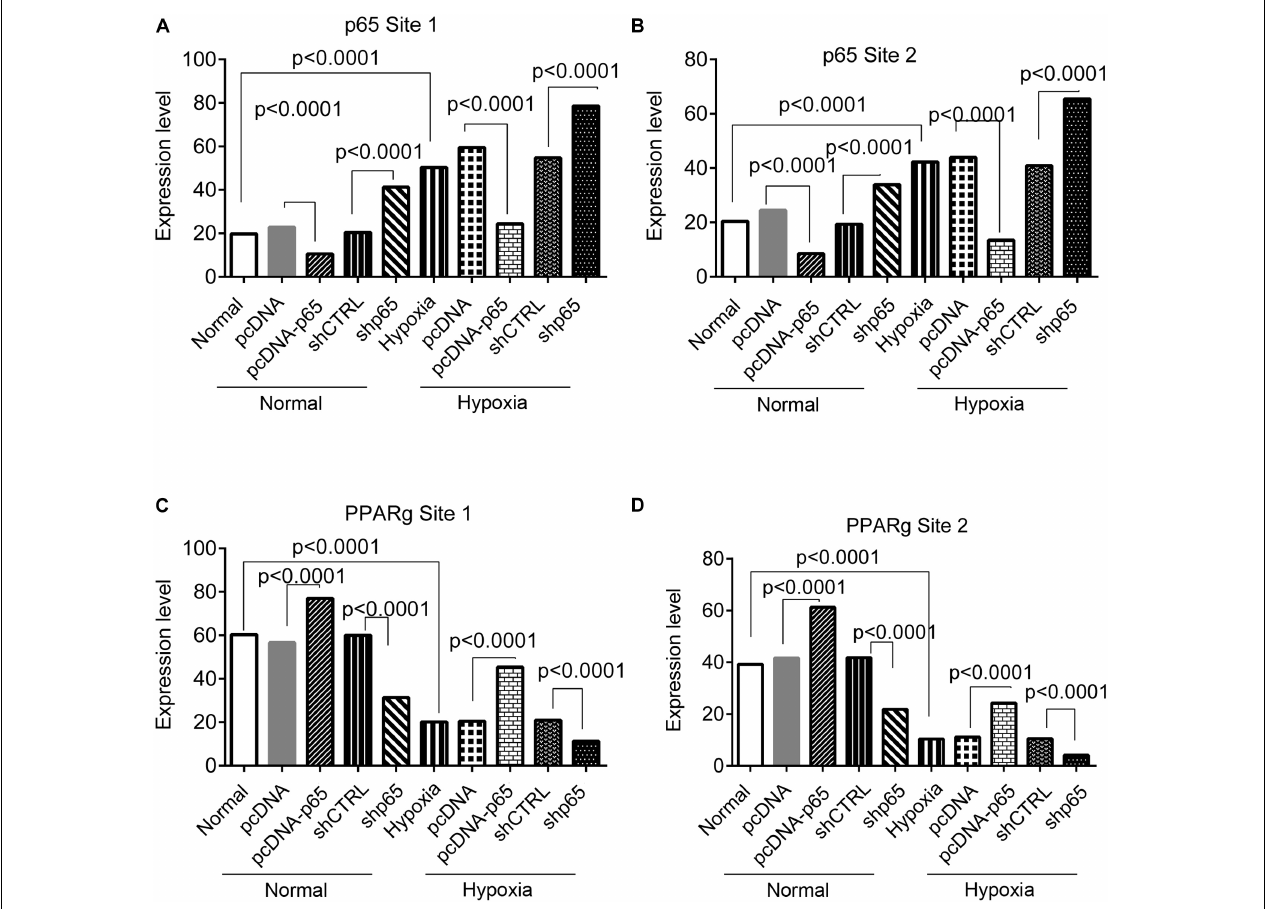
FIGURE 9 | The ChIP-PCR analysis for the binding of the p65 and PPAR γ proteins in the promoter regions of the TRPC6 gene in response to PPAR γ overexpression or inhibition. (A,B) The PCR results of the DNA fragments, including the promoter regions of the TRPC6 gene (site 1 and site 2 in Figure 7 ) enriched by the p65 antibody. (C,D) The PCR results of the DNA fragments, including the promoter regions of the TRPC6 gene (site 1 and site 3 in Figure 7 ) enriched by the PPAR γ antibody. Each experiment was repeated three times. The differences were analyzed using one-way ANOVA. CTRL,